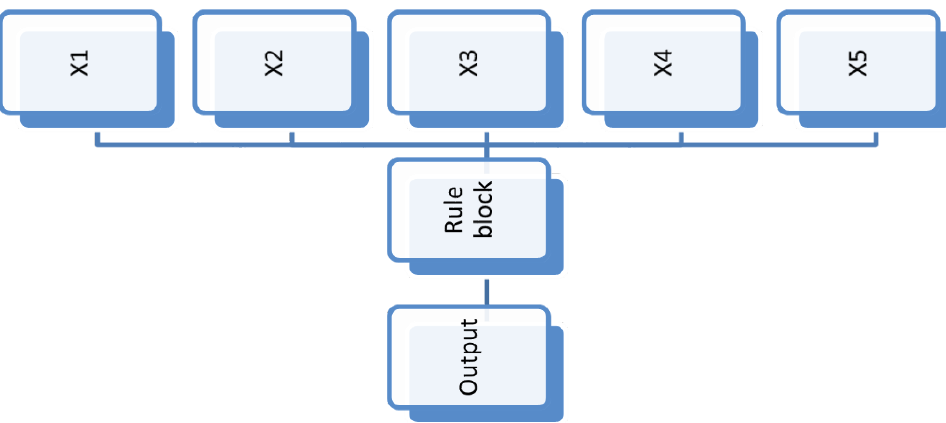
Figure 5. The structure of the fuzzy logic model. Source: based on the author’s own studies.